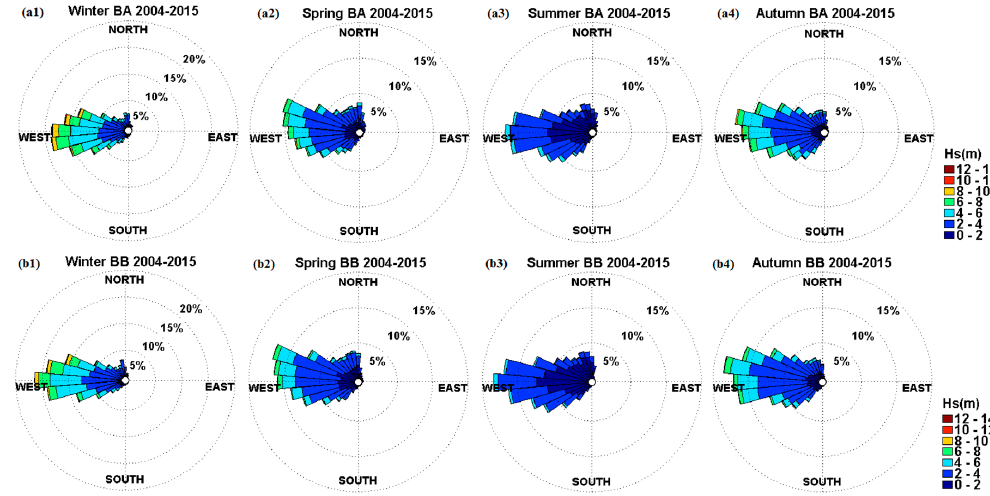
Figure 10. 12-year seasonal wave roses between H s and MWD at ( a1 – a4 ) BA and ( b1 – b4 ) BB.